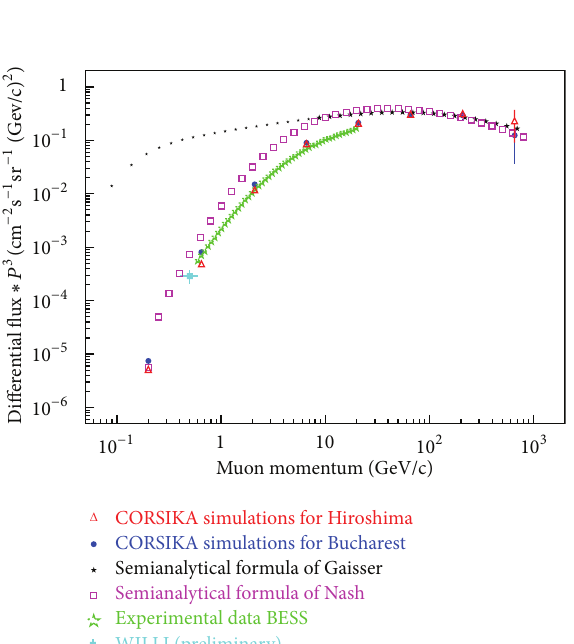
Figure 6: Comparison between the muon flux obtained by COR- SIKA with experimental results obtained by BESS [40] and semian- alytical formulae of Nash [37] and Gaisser [35, 39, 41, 42].